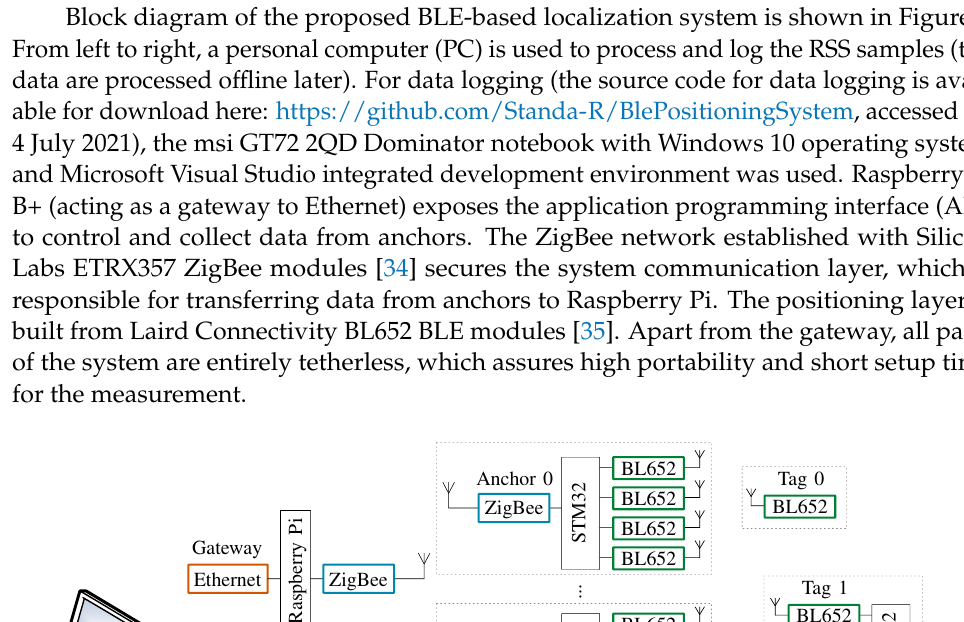
Figure 1. Timing of advertisement transmission and reception. The BLE module sends three identical Fig. 2. Timing of advertisement transmission and reception. The BLE consecutive advertising packets on different advertisement channels on every advertising event. module sends three identical consecutive advertising packets on different The scanner receives only one report depending on the listening channel. It can actively listen for advertisement channels on every advertising event. The scanner receives only the whole Scan Interval or only a part of it. Time marks are relative to the Advertiser or Scanner one report depending on the listening channel. It can actively listen for the and as such they are intentionally misaligned to illustrate the real-world situations, where the BLE whole Scan Interval or only a part of it. Time marks are relative to the communication is not synchronized. Advertiser or Scanner and as such they are intentionally misaligned. Therefore, the impact of active BLE devices on RF noise is about the same as in the remote positioning system. Block diagram of the proposed BLE-based localization system is shown in Figure 2.